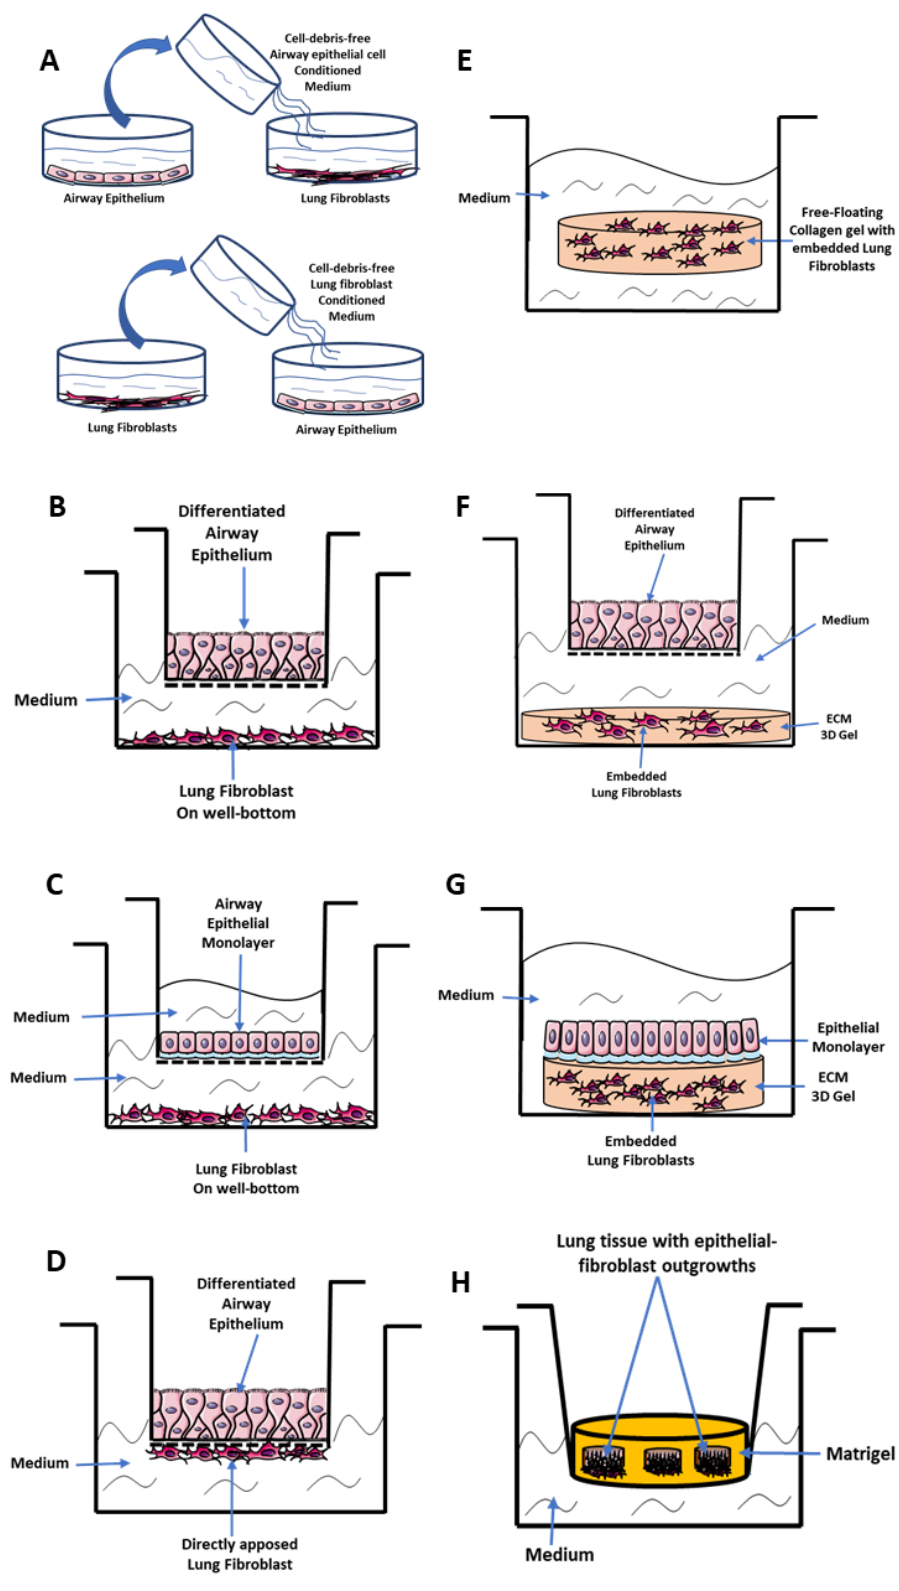
Figure 2. In vitro co-culture models of epithelial-mesenchymal crosstalk in asthma. ( A ) Conditioned medium exposure models where cell-debris free medium from cultured epithelial cells is placed on